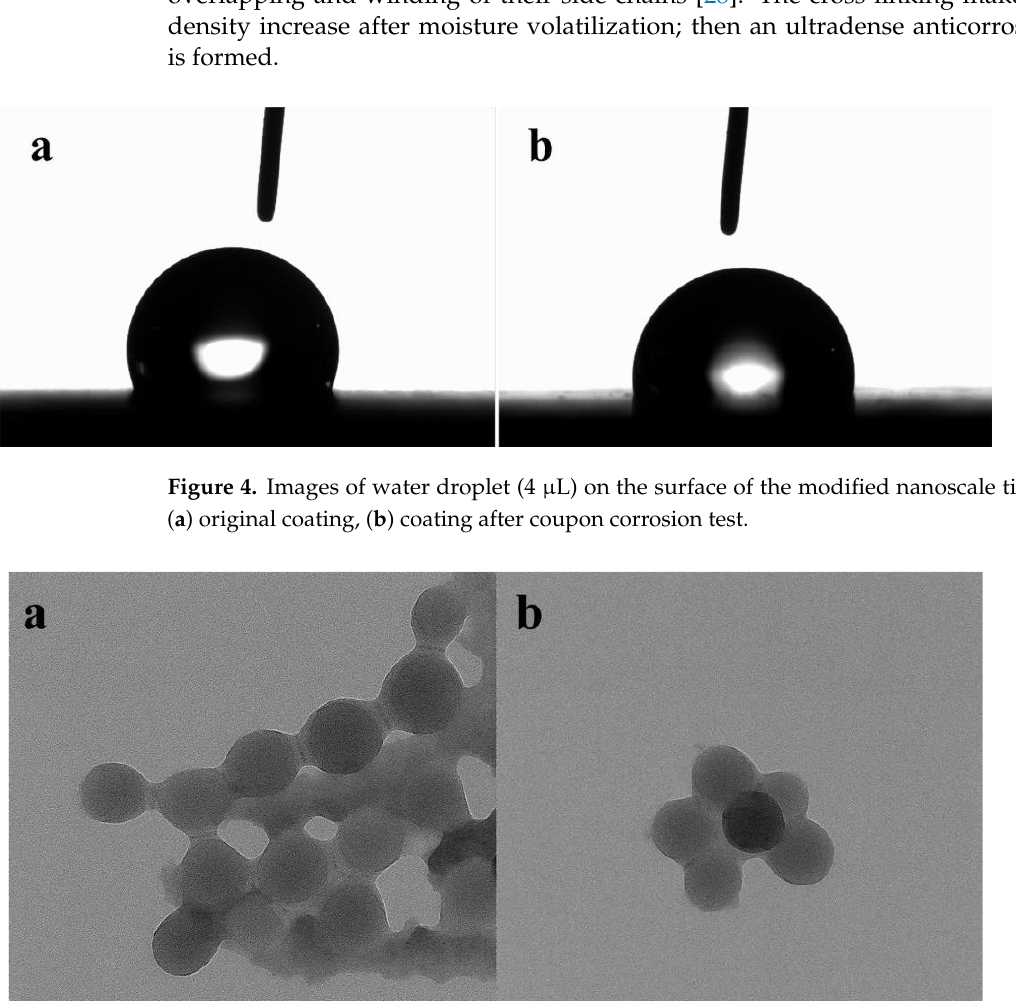
Figure 3. AFM images of the modified nanoscale titania coating: ( a ) 3D stereogram, ( b ) 2D topogra- phy.